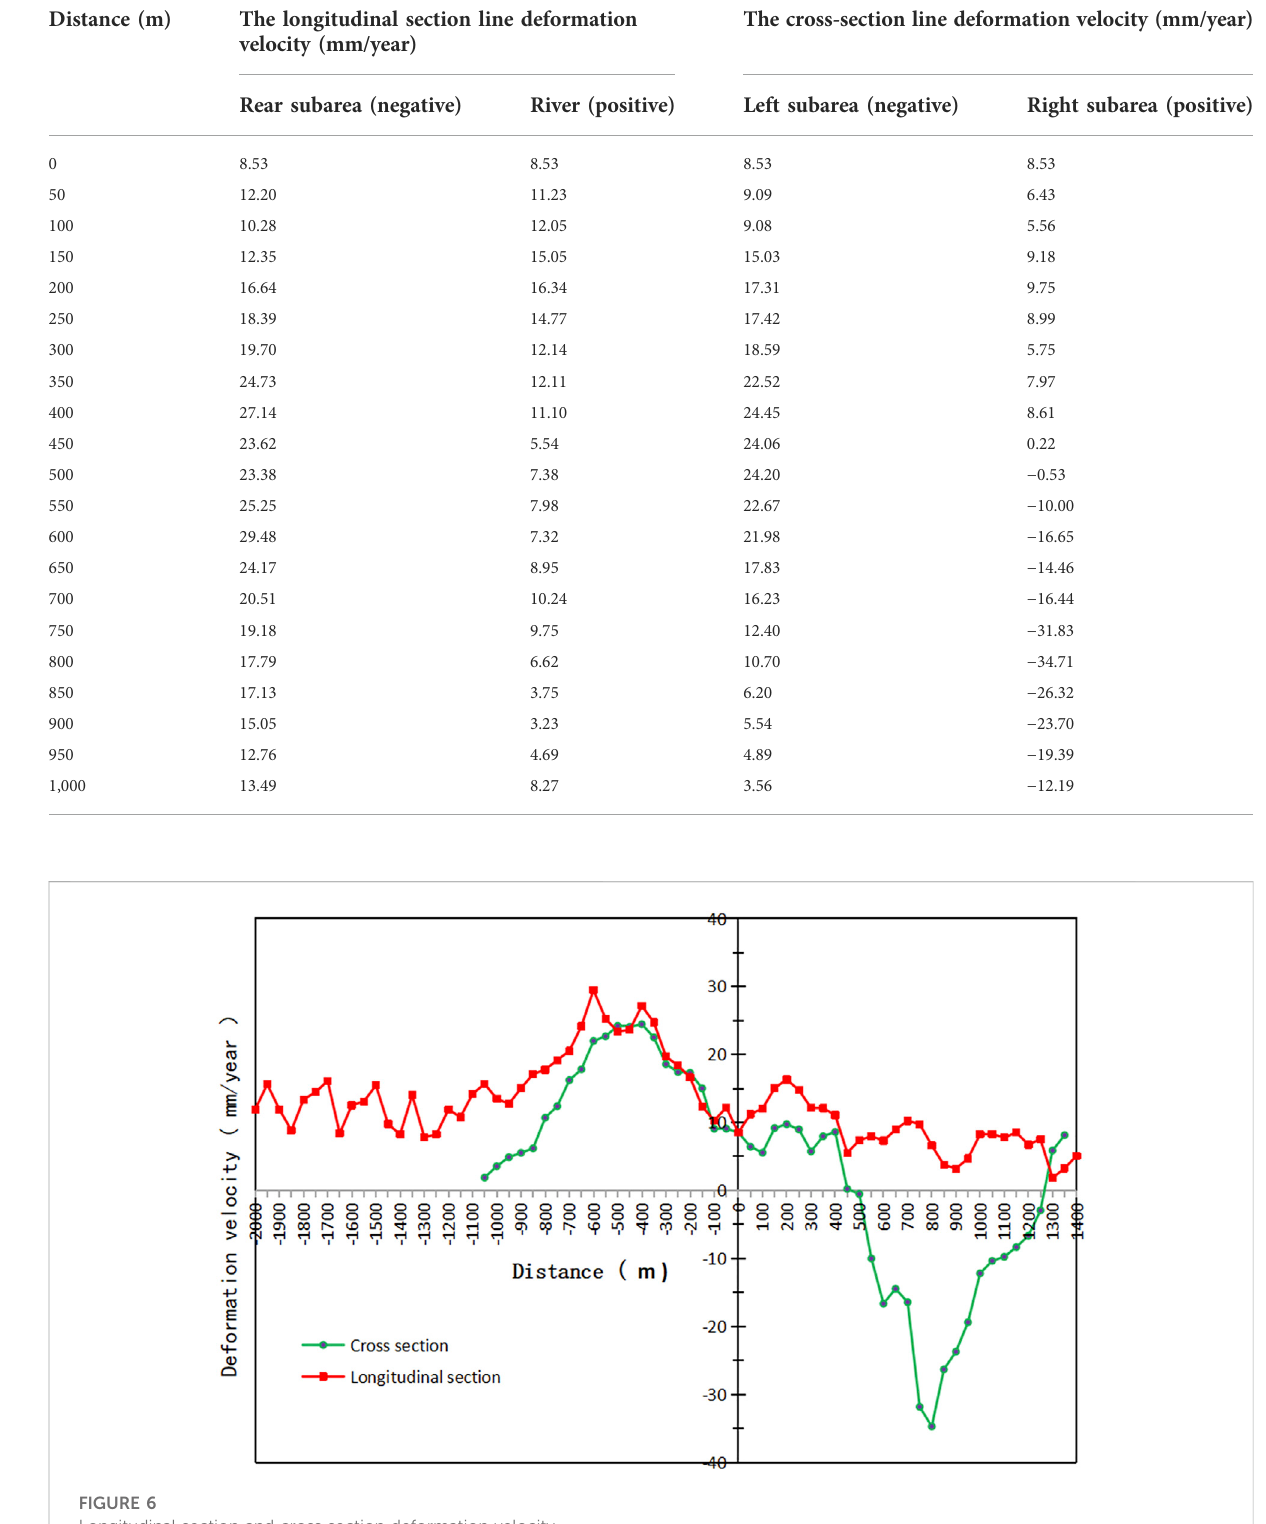
TABLE 2 The deformation velocity of sampling points in the debris fl ow source area.